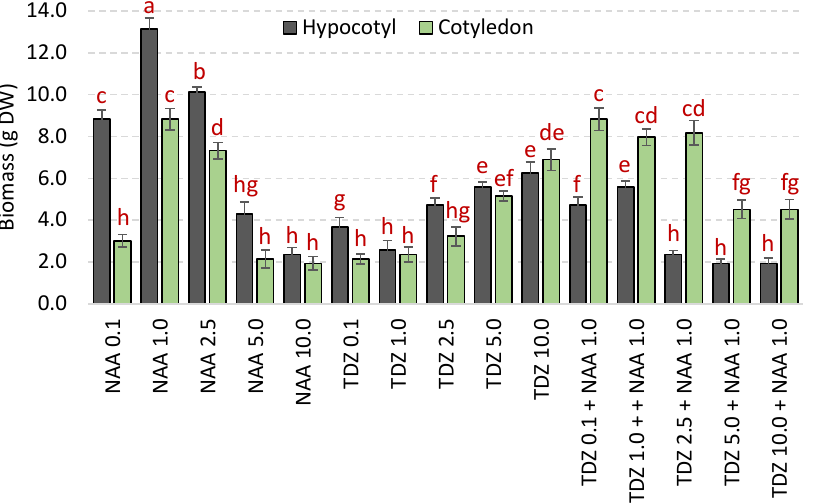
Figure 2. Comparison of biomass dry weight (DW) accumulation for hypocotyl- and cotyledon- derived callus cultures of L. grandiflorum grown on various plant growth regulators (PGRs; i.e., NAA and/or TDZ) treatments. NAA and TDZ concentrations are indicated in mg/L. Different letters indicate significant difference ( p < 0.05).